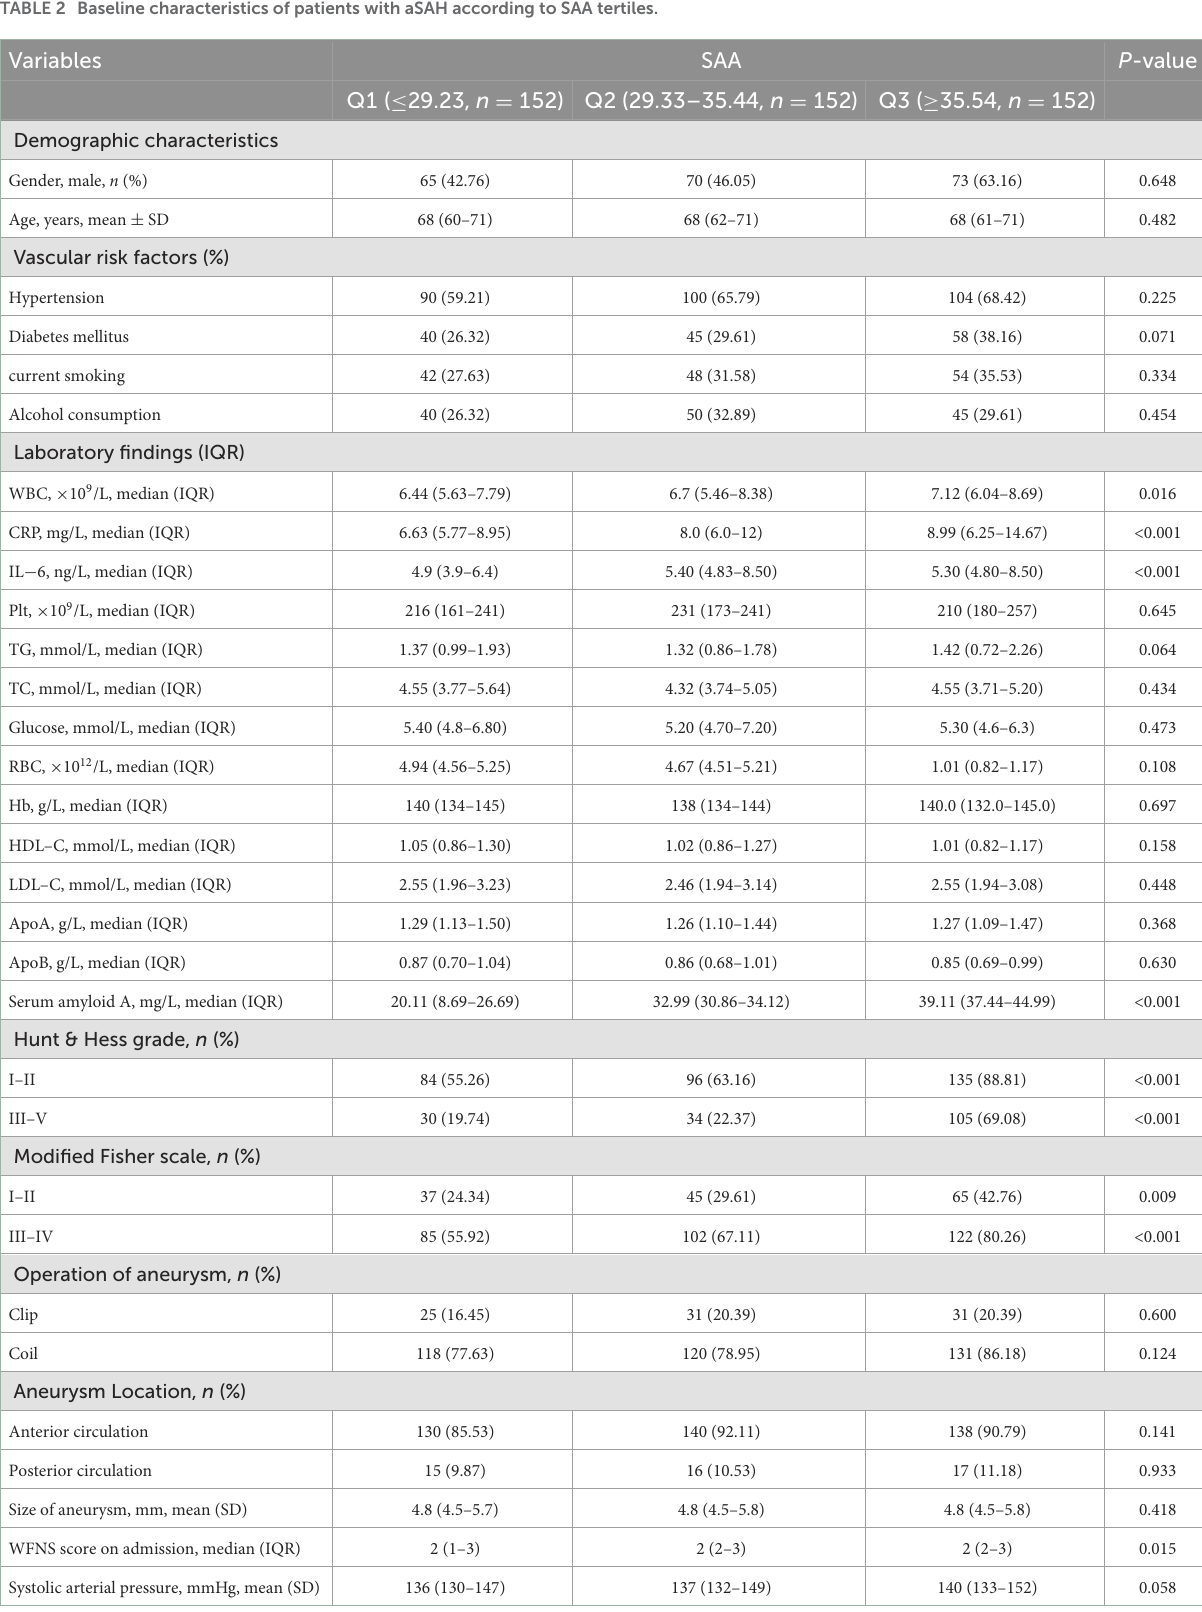
TABLE 2 Baseline characteristics of patients with aSAH according to SAA